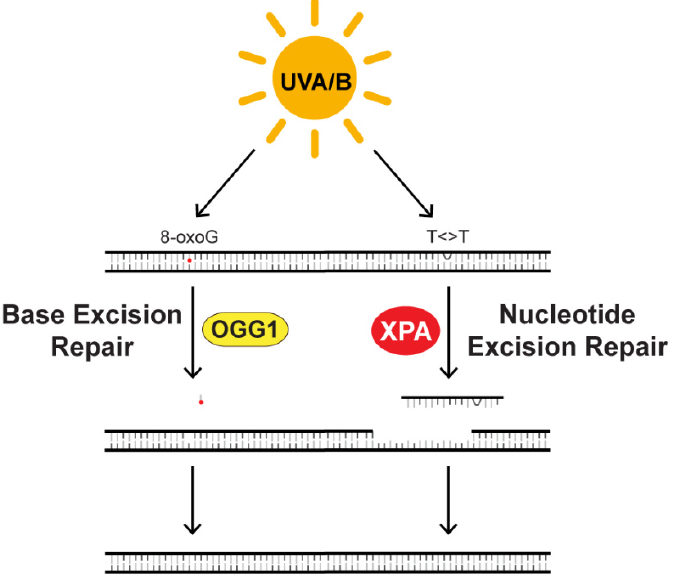
Figure 5. UV radiation causes the formation of lesions in DNA that are targeted for removal by DNA repair. UVA and UVB wavelengths of sunlight induce the formation of oxidative lesions in DNA, such as 8-oxoguanine (8-oxoG). These small-base lesions are targeted for removal by base excision repair (BER). UV radiation also induces the formation of photoproducts between adjacent pyrimidines in DNA (T<>T) that can only be removed by the nucleotide excision repair (NER) system. Research has shown that the expression or activity of both the BER protein OGG1 and (8-oxoguanine DNA glycosylase) and NER protein XPA (xeroderma pigmentosum group A) are controlled by the circadian clock in various organ systems.